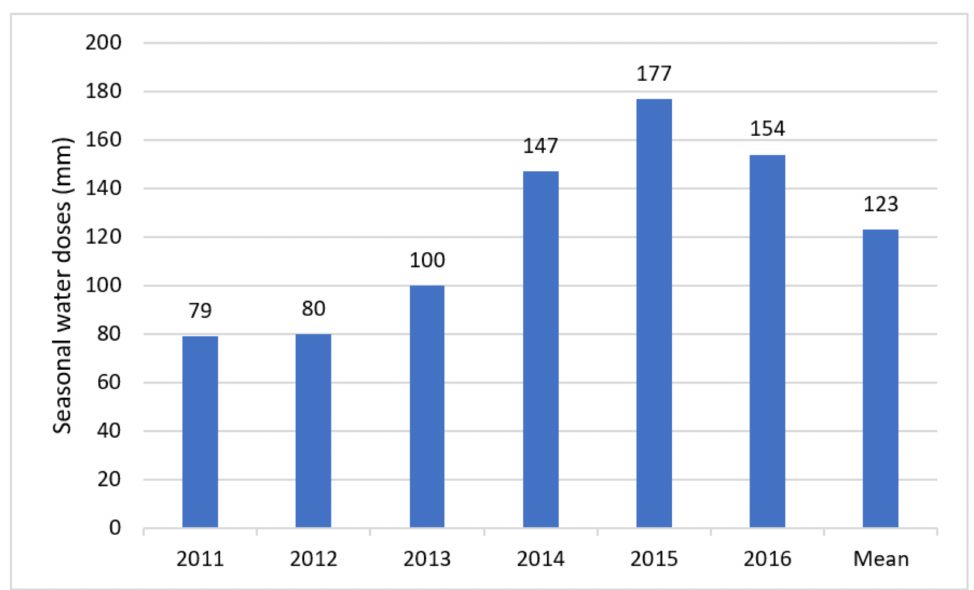
Figure 1. Seasonal water doses (mm) for asparagus plants in the years 2011–2016.